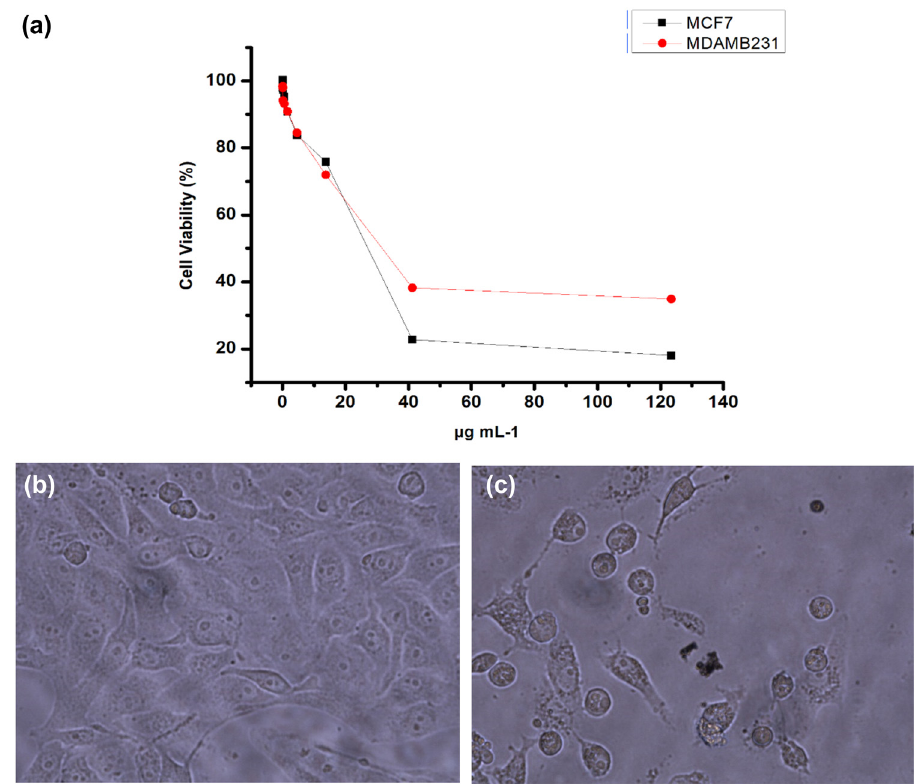
Figure 3: ( a ) Cytotoxic activity of 5d on MCF - 7 and MDA - MB - 231 cells using MTT assay; ( b ) control; and ( c ) cells treated with 5d showing shrinkage and detachment from the surface ( 24 h )